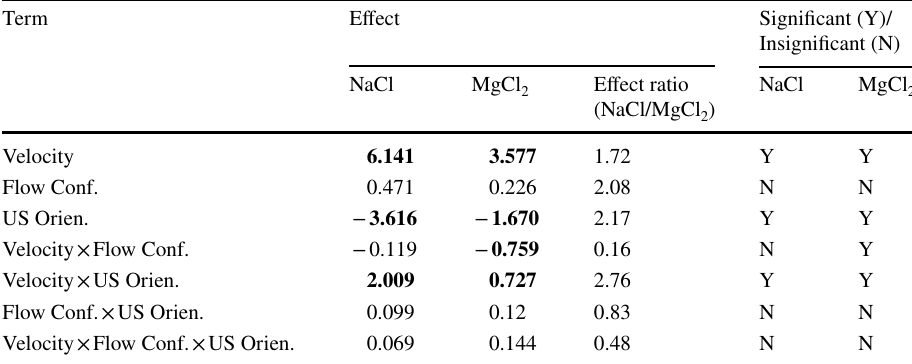
Bold values indivcated by the 95% confidence